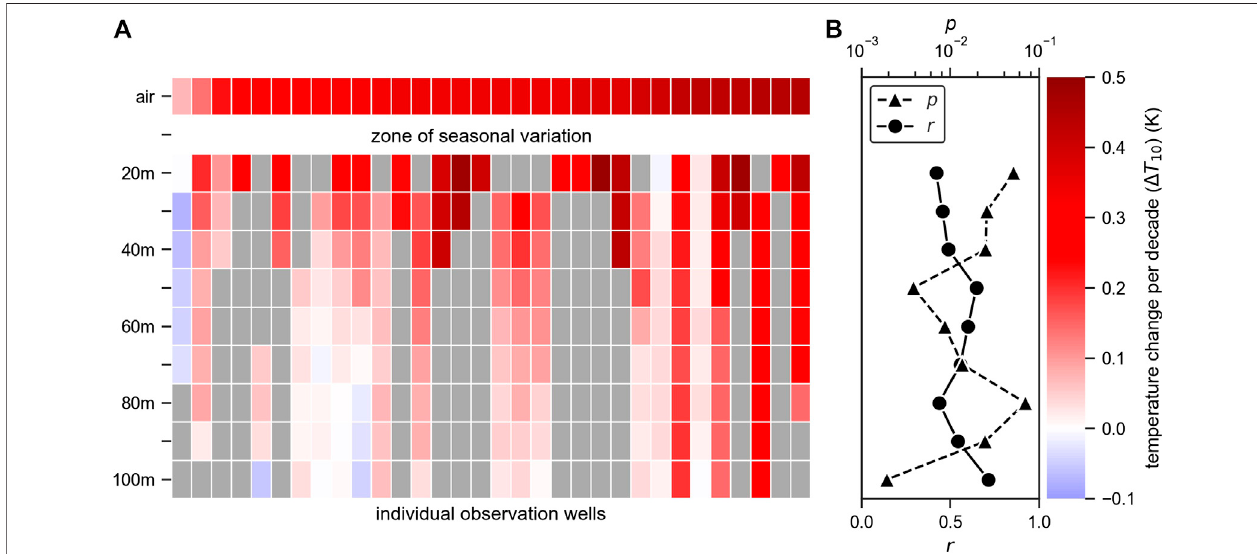
FIGURE 3 | (A) Heatmap showing the temperature change per decade ( Δ T 10 ) for air temperature (AT) of the period from 1990 to 2018 and for groundwater temperature (GWT) calculated from temperature-depth pro fi les measured in 2019 and 1992 – 1994. Air temperature is inferred for each observation well location. Values at 10 m depth have been masked for showing high seasonal variability. Observation wells are sorted by their AT lapse rates. Empty cells are displayed in gray. (B) Pearson correlation coef fi cient ( r ) and p -value ( p ) for GWT at each depths.